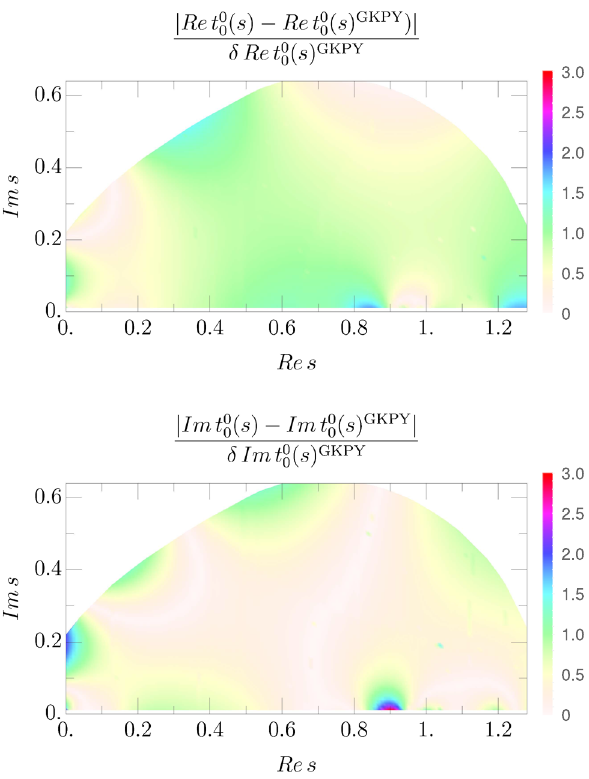
Fig. 4 Within the applicability region of GKPY equations in the complex- s plane,weshowtheabsolutevalueofthedifferencesbetween the real (top) and imaginary (bottom) parts of the global parameteriza- tion and the GKPY equations, divided by the uncertainty of the latter. WeplotresultsforsolutionIbut theothertwoareidenticalinthisregion